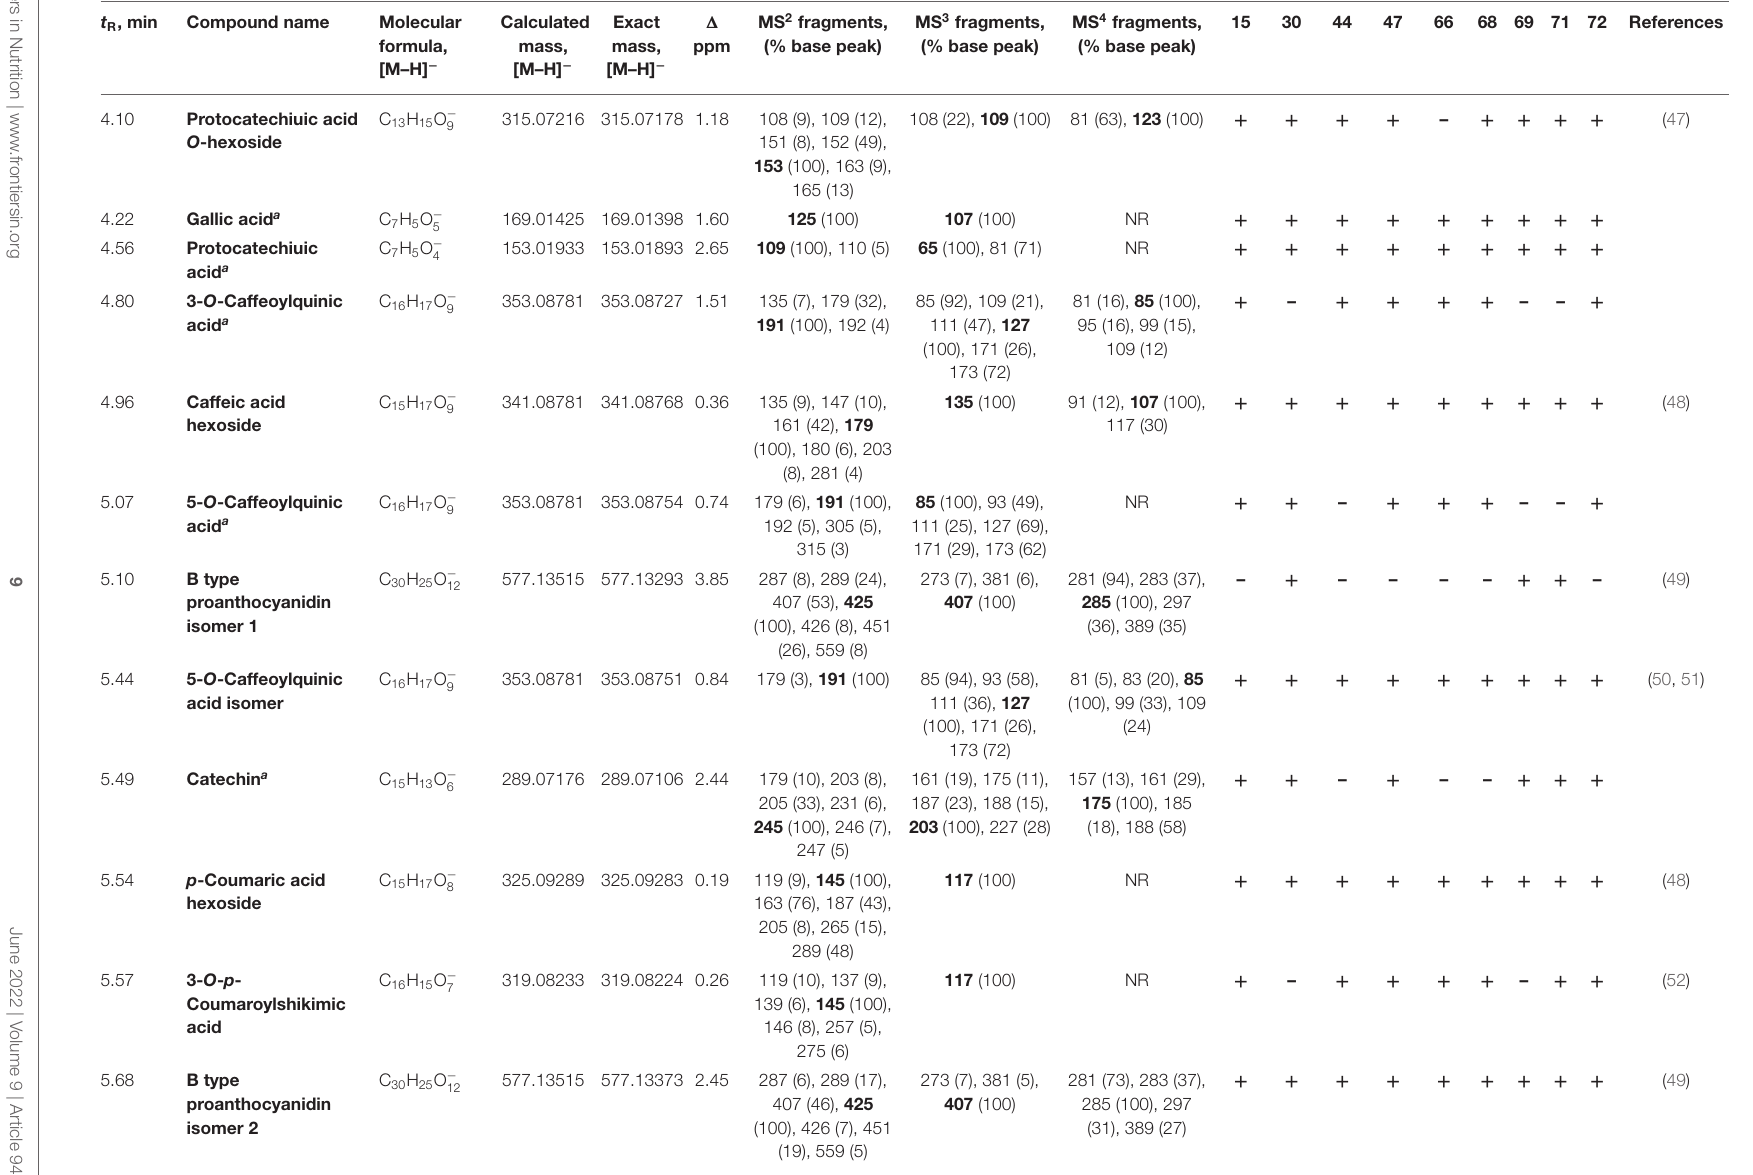
TABLE 5 | Phenolic profile of nine Norwegian apple samples from the NIBIO Ullensvang area (sample no. 15 “Furuholm,” “Fuhr,” no. 30 “Kaupanger,” no. 44 “Prins,” no. 47 “Raud Gravenstein,” no. 66 “Tormodseple,” no. 68 “Tveiteple,” no. 69 “Ulgenes,” no. 71 “Vanleg Torstein,” and no. 72